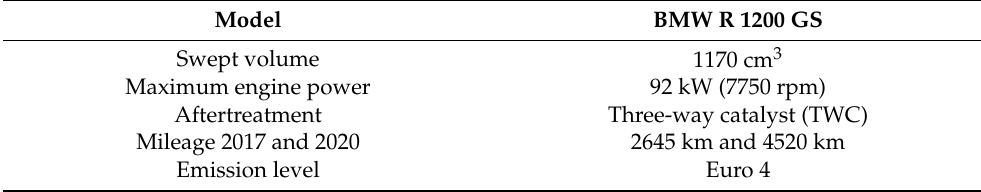
Table 3. Characteristics of the